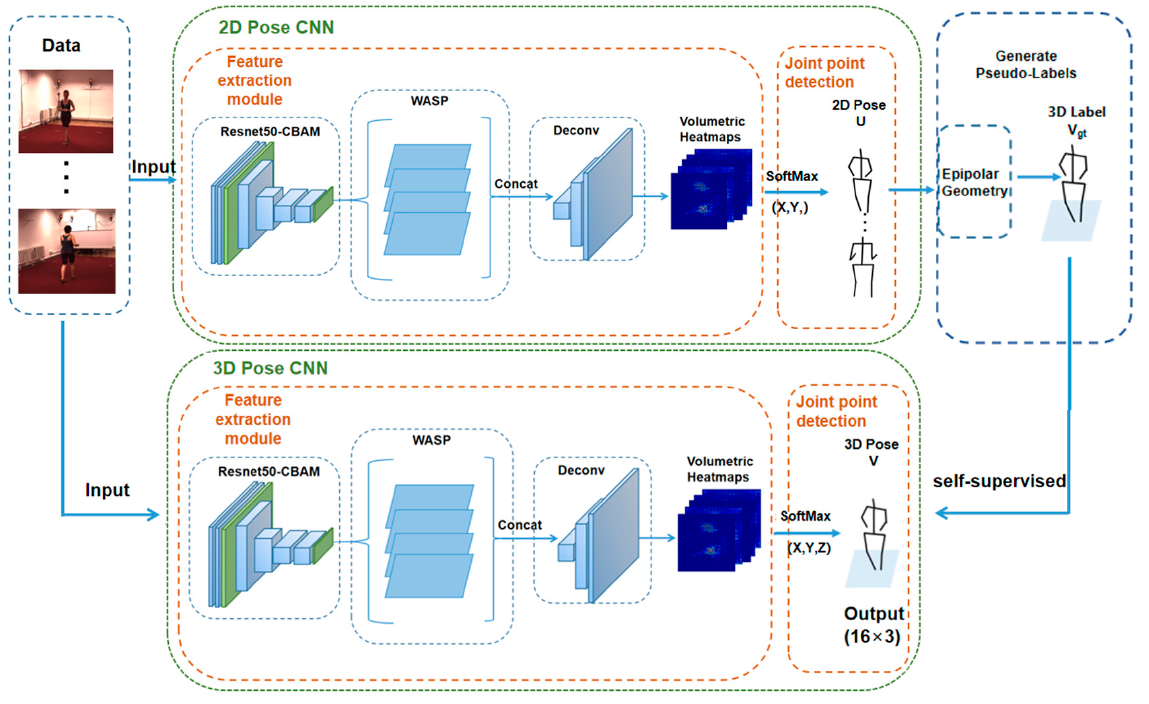
Figure 1. Structure of Pose ResNet.